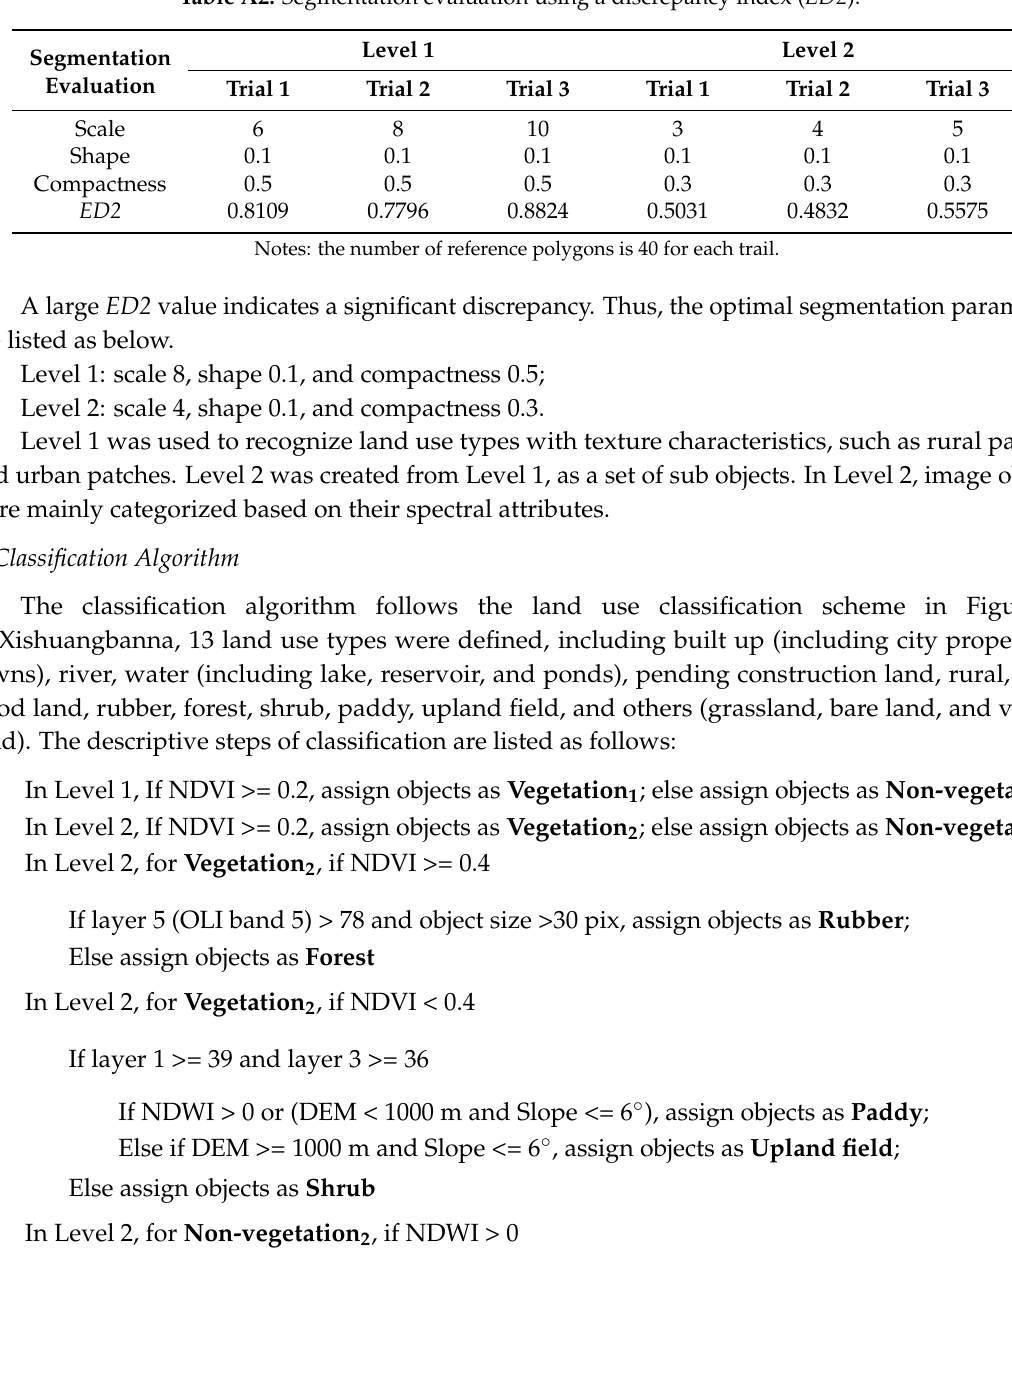
Table A2. Segmentation evaluation using a discrepancy index ( ED2